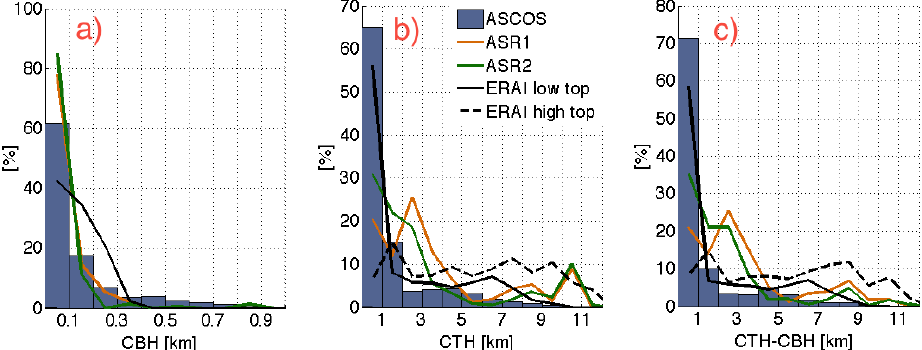
Fig. 11. Histograms (%) of the cloud boundaries showing (a) cloud-base height (CBH), (b) cloud-top height (CTH) and (c) cloud thickness (CTH–CBH) in kilometers. The bars (grey) show results from the ASCOS observations and each of the lines represent results from ASR1 (orange), ASR2 (green) and ERA-Interim (black).